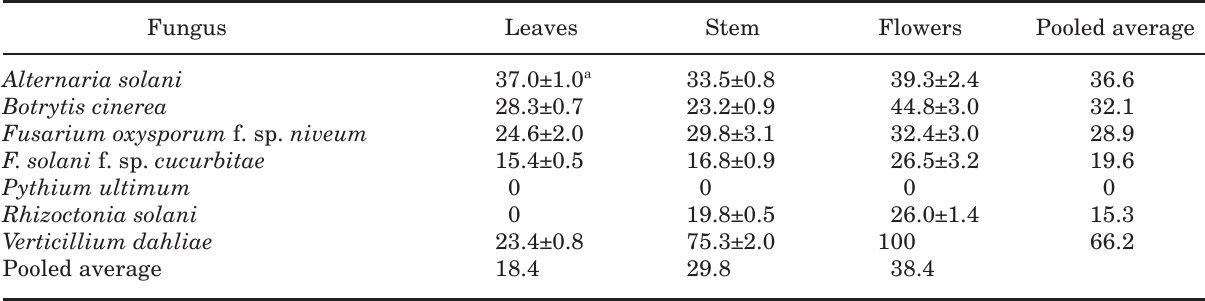
Table 4. Inhibition (%) of fungal growth with different parts of Hibiscus rosa-sinensis cv. red flower.